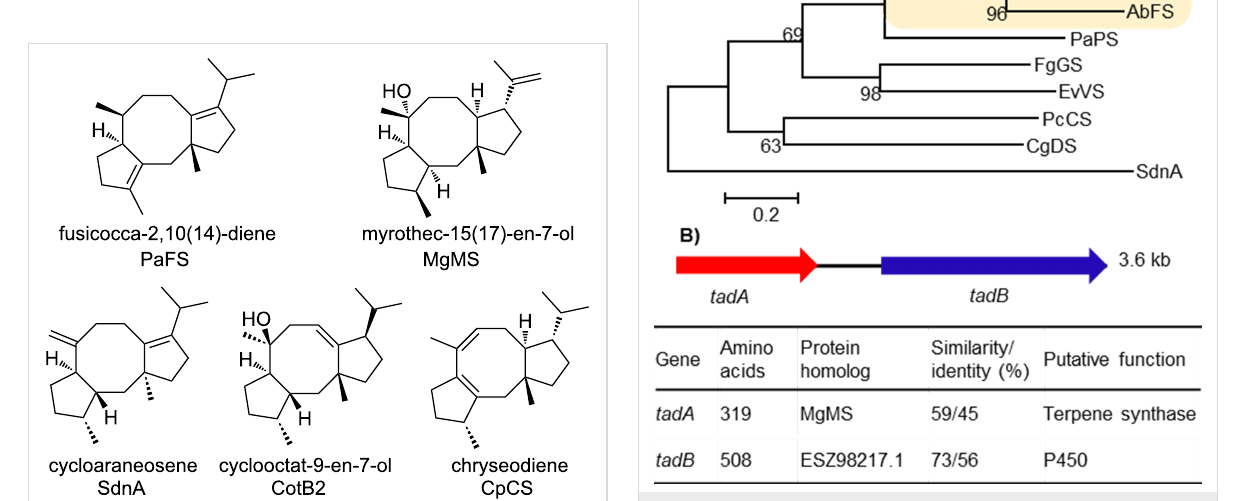
Figure 2: Bioinformatics analysis of the tad cluster. A) Phylogenetic tree of TadA and representative fungal DTSs. B) Putative functions of the tad